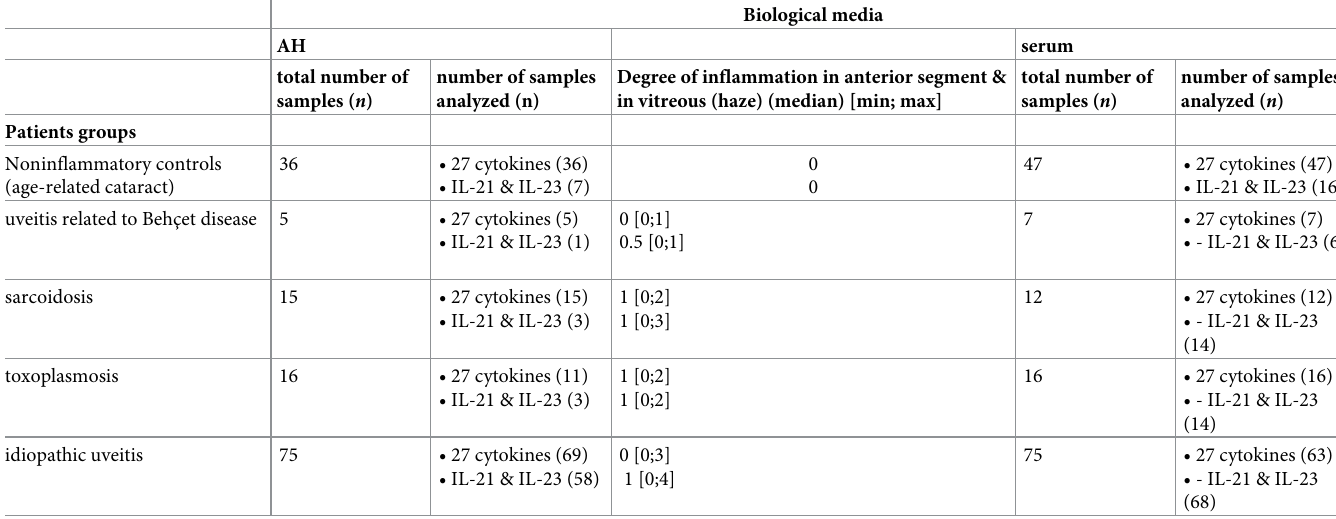
Table 1. Total number of paired AH and serum samples analyzed.